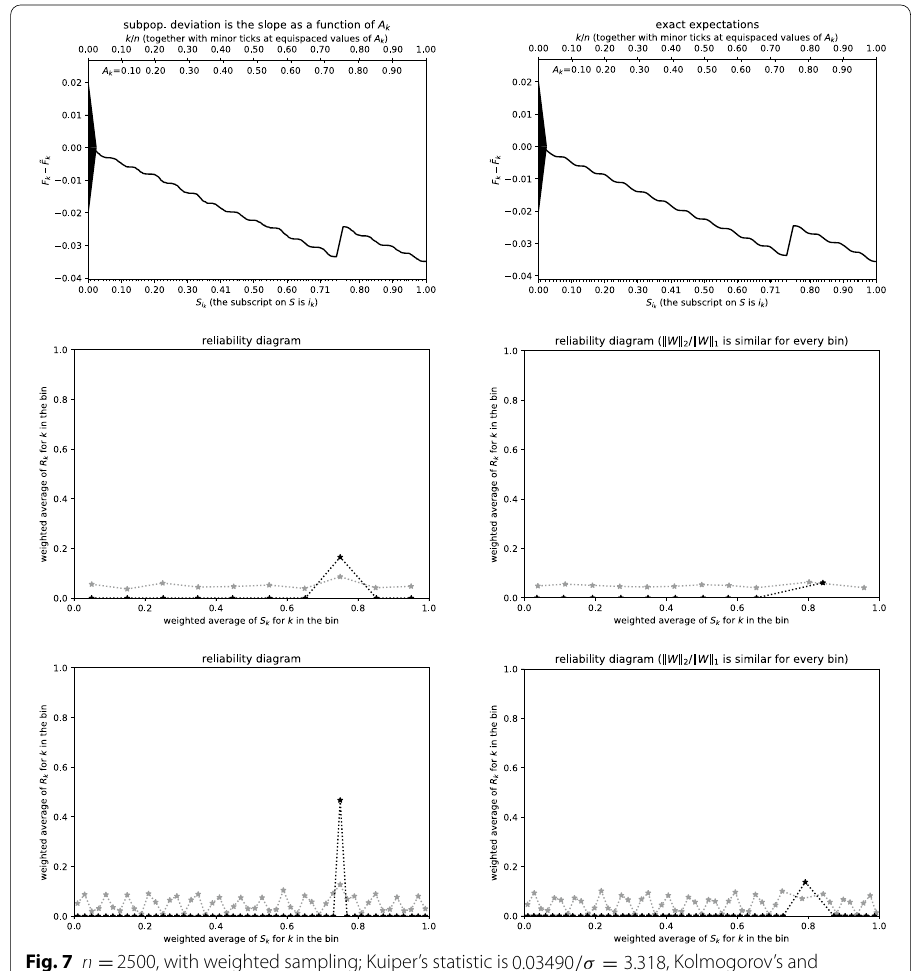
Fig. 7 n = 2500, with weighted sampling; Kuiper’s statistic is 0.03490 /σ = 3.318 , Kolmogorov’s and Smirnov’s is 0.03490 /σ = 3.318 . Figure 8 displays the ground-truth reliability diagram. The cumulative plot displays the distinguished observation from the subpopulation as a straight, steep jump at its score around 0.75; the constant slope of that steep jump shows that the corresponding high deviation between the subpopulation and the full population is due to a single highly weighted observation. This single observation has no effect on the slopes in the rest of the cumulative plot, whereas the few highly weighted observations dramatically (perhaps misleadingly?) alter the bins around scores of 0.75 in the observed reliability diagrams. The scalar summary statistics report statistically significant deviation of the subpopulation from the full population, though the steep jump in the cumulative plot reduces the effectiveness of the scalar